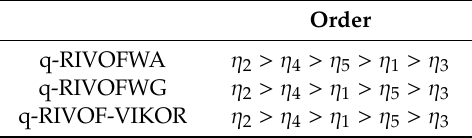
Table 7. Order of alternatives by q-RIVOFWA and q-RIVOFWG